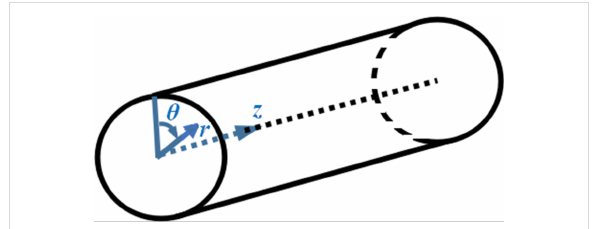
Figure 1: Schematic drawing of the circular